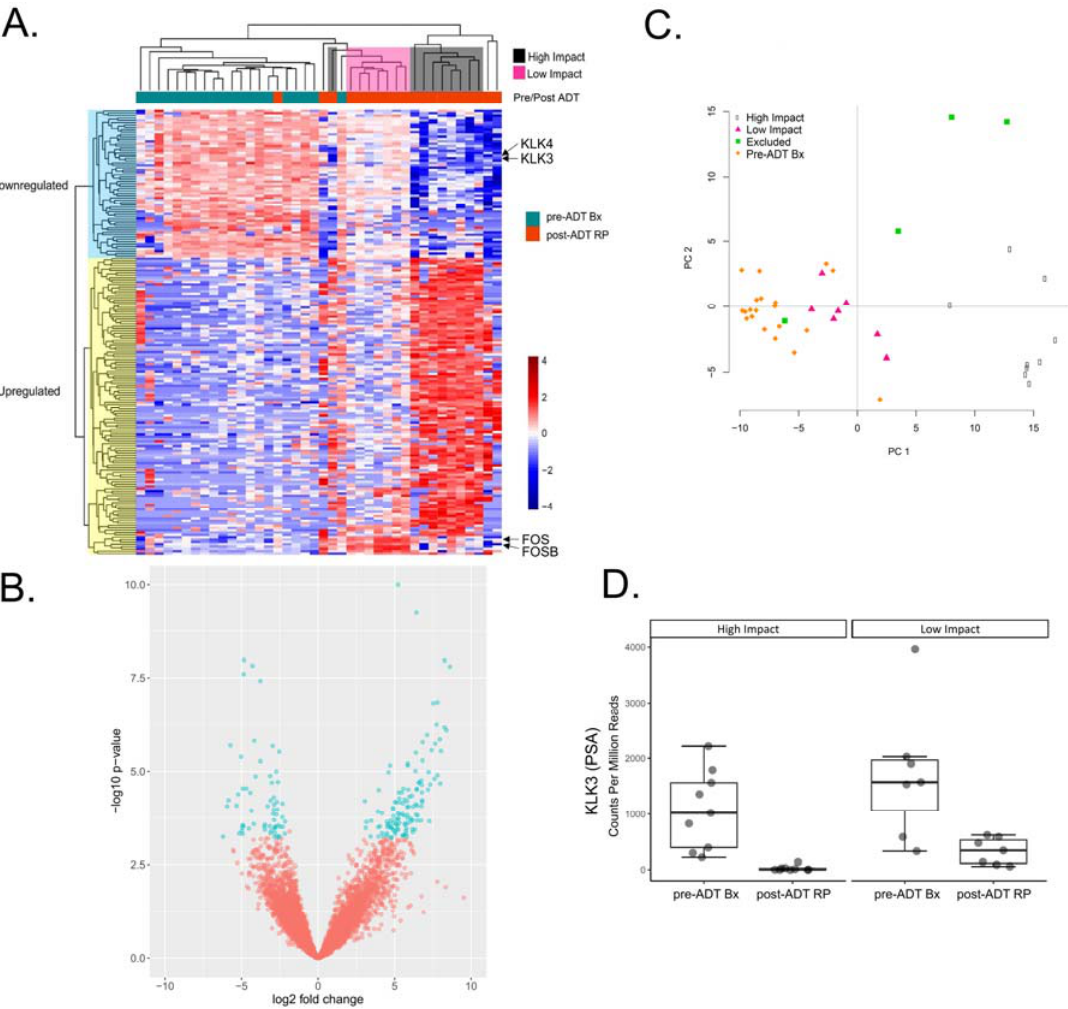
Figure 1. The hierarchical clustering and principal component analysis (PCA) of 190 significantly differentially expressed genes in 20 matched Pre-ADT biopsies and Post-ADT radical prostatectomies (RPs). ( A ) Clustering reveals two groups of Post-ADT RPs displaying segregated based on the expression of upregulated and downregulated genes (high- or low-impact groups, respectively); ( B ) Volcano plot highlighting 190 significantly differentially expressed genes; ( C ) PCA reveals 4 post-ADT RP samples as not clustering with either the high or low impact groups; ( D ) Boxplot depicting KLK3 expression in counts per million mapped reads demonstrates that the decrease in the KLK3 expression is significantly more pronounced in the high impact group than in the low impact group.